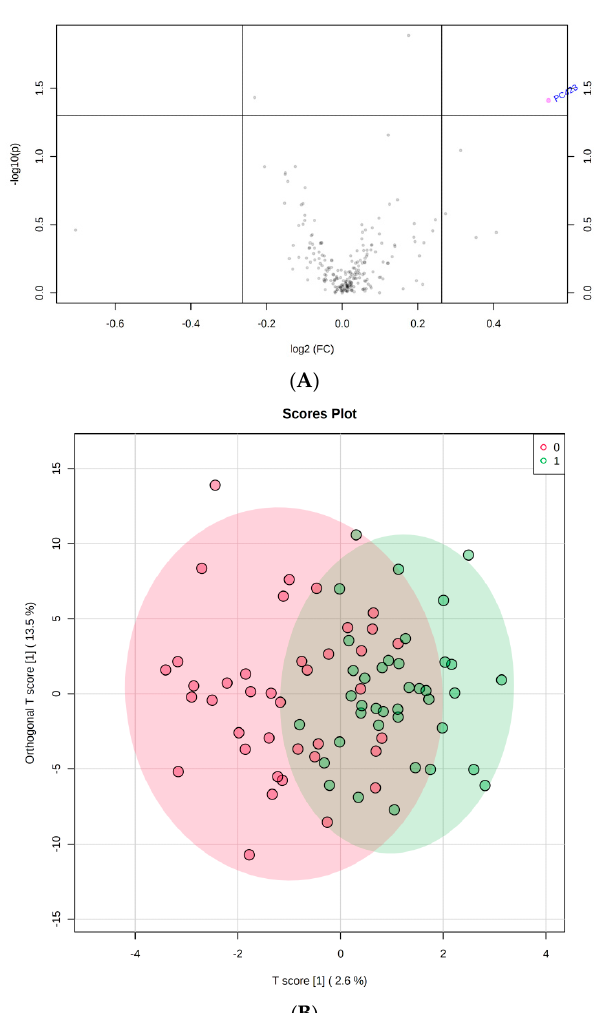
Figure 2. ( A ) volcano plot and ( B ) OPLSDA. Metabolites 2020 , 10 , x FOR PEER REVIEW